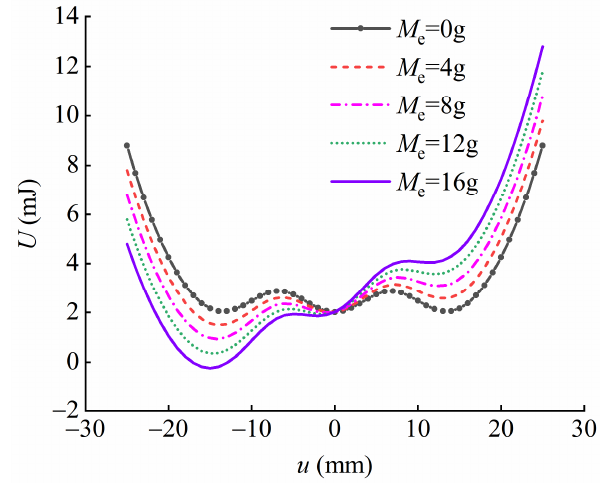
Figure 7. System’s potential energy curve under different M e